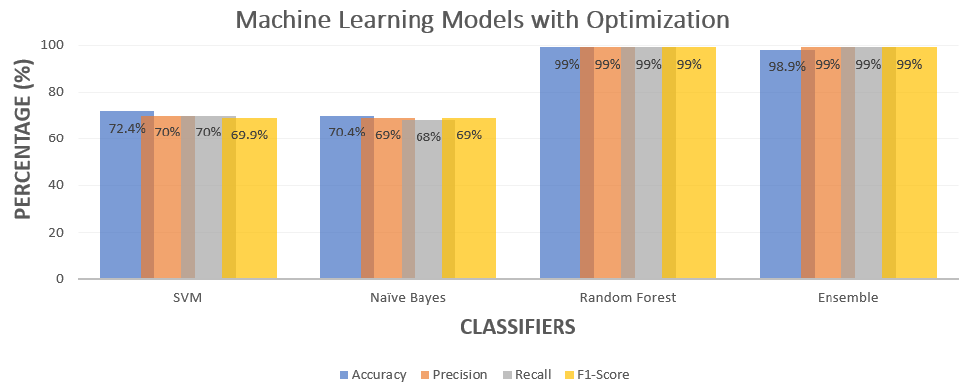
Figure 18. The Classification Results After Optimization.